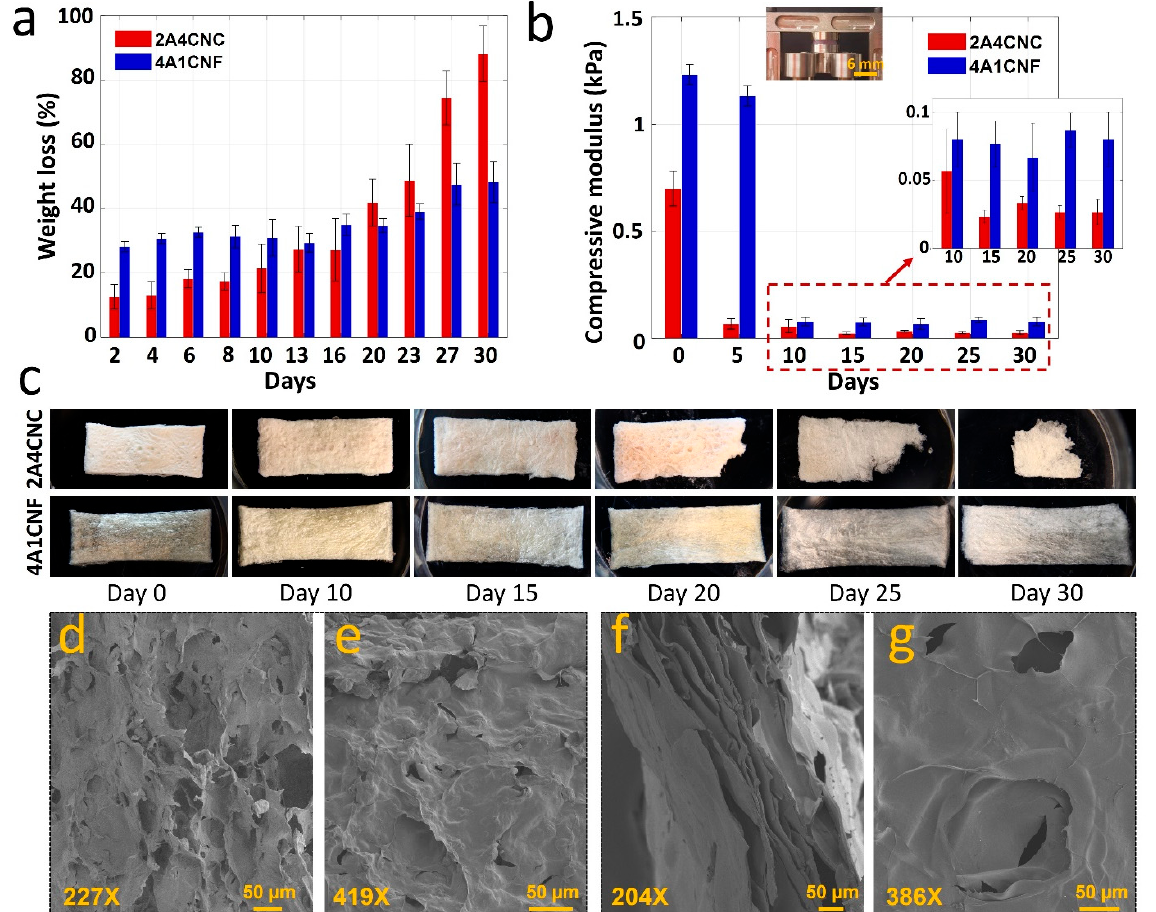
Figure 5. In vitro degradation of printed constructs. ( a ) Weight loss (%) of two samples in cell culture media containing Dulbecco’s modified Eagle’s medium (DMEM) with 10% fetal bovine serum (FBS) over a month. ( b ) The compressive modulus of samples ( l × w × h = 10 × 10 × 2 mm ) was compared with the time of exposure to the cell culture media for 5-day periods up to one month. Inlet: a representative image of a sample undergoing a compression test by a dynamic mechanical analyzer (DMA). Statistical differences were calculated by one-way ANOVA test for multiple comparisons ( p < 0.0001). ( c ) Pictorial representative images of washed and freeze-dried samples after withdrawal from the media in 5 days period. Error bars represent the standard deviation of 3 independent measurements. Scanning electron microscope (SEM) images of freeze-dried ( d ) 2A4CNC on day 0, ( e ) 2A4CNC after 10-day degradation, ( f ) 4A1CNF on day 0, and ( g ) 4A1CNF after 10-day degradation.